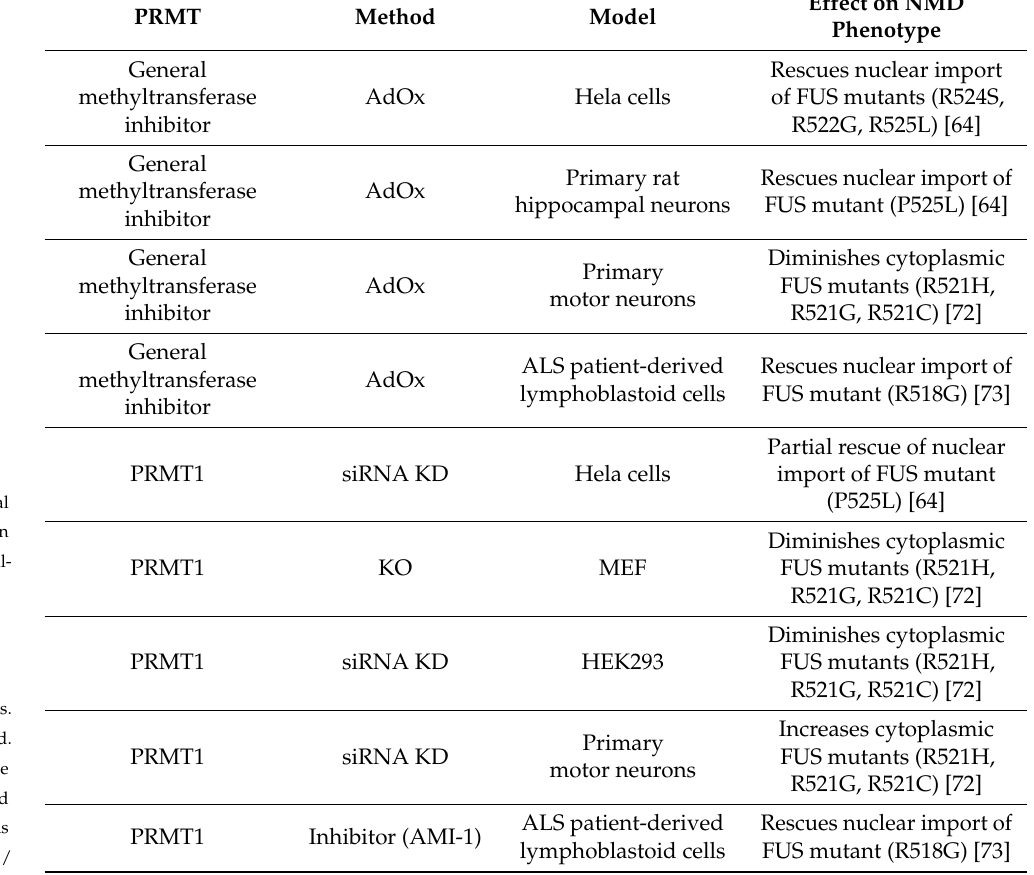
Table 1. Effect of targeting PRMTs on NMD